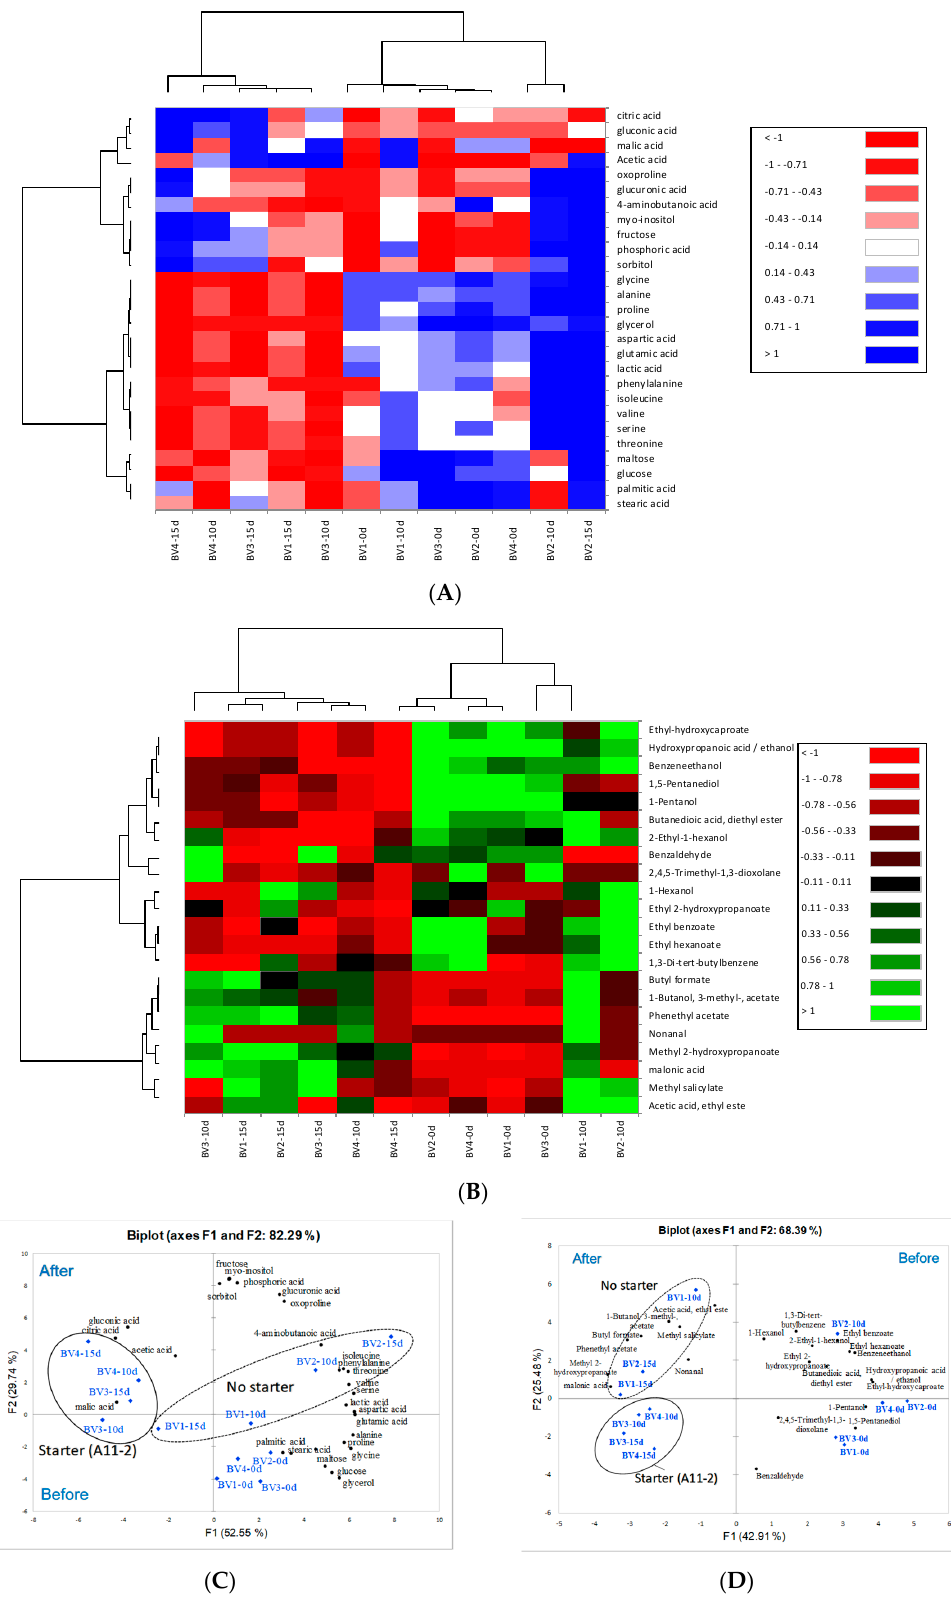
Figure 2. Heatmap and principal component analysis (PCA) of metabolites and aromatic volatile compounds outlining bellflower root vinegar during fermentation. ( A ) metabolites, ( B ) aromatic volatile compounds, ( C ) and ( D ), expressed by PCA analysis.